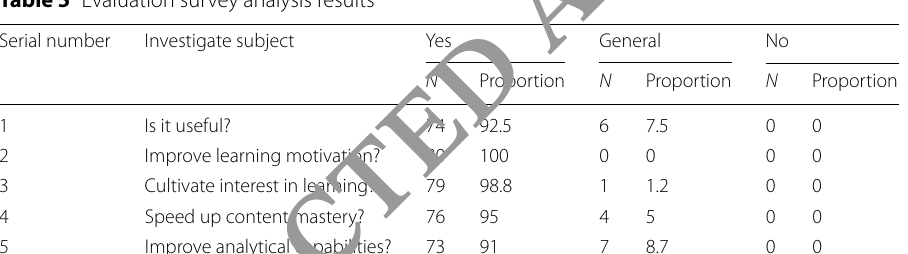
Fig. 5 Comparison results between groups